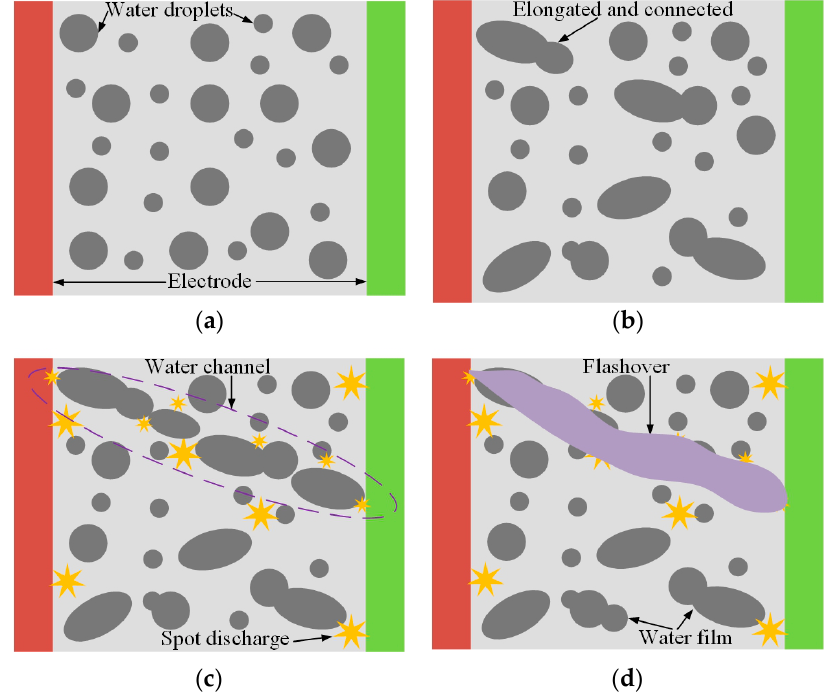
Figure 8. Development of flashover of HTV SR sample in salt-fog environment. ( a ) Water drops deposit, ( b ) water drops deformation, ( c ) partial discharge, ( d ) flashover.